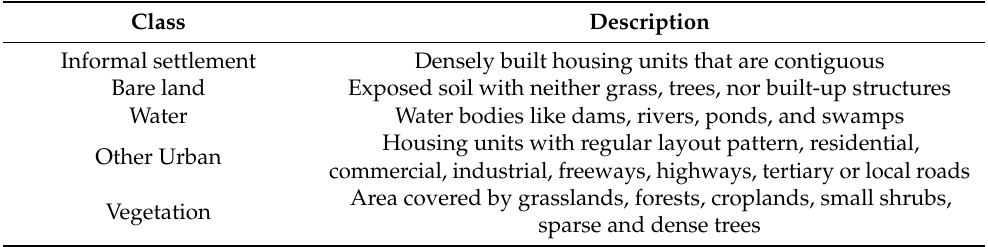
Table 3. The definitions of Land Use/Land Cover